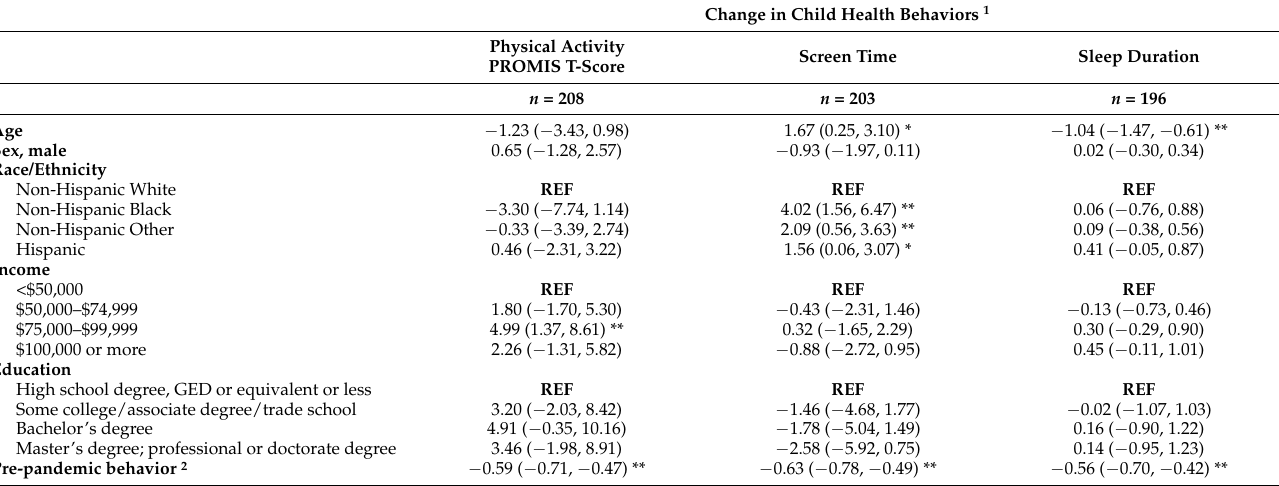
1 Odds ratios (95% CI) from ordinal regression models represent the odds of changing outcome categories. Models are adjusted for covariates shown in table and cohort. GED, general educational development. * p < 0.05; ** p < 0.01. Table 4. Associations between sociodemographic characteristics and changes in physical activity, screen time, and sleep duration among children ages 4–12 in 4 cohorts participating in the Environ- mental influences on Child Health Outcomes Program.